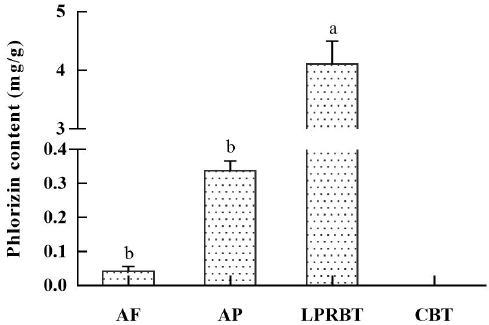
Figure 1. Phlorizin content in AF, AP, LPRBT, and CBT. AF: apple flesh; AP: apple peel; LPRBT: L. polystachyus black tea; CBT: traditional black tea. Error bars indicate standard error (SE). Letter designations identify homogeneous groups. Different letters represent significant differences ( p < 0.05).